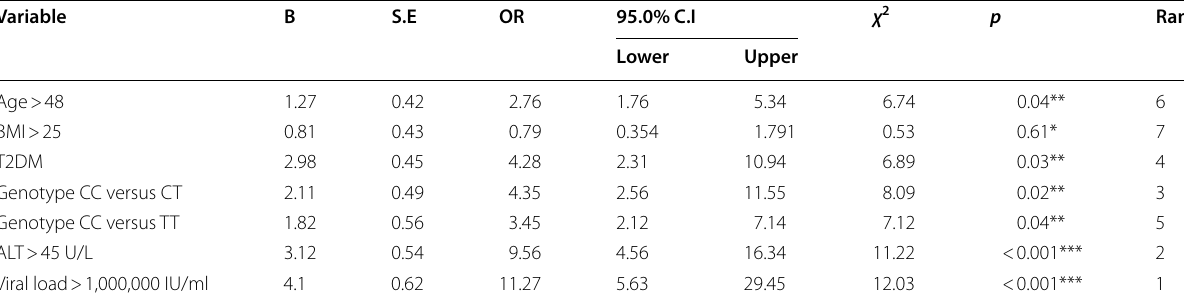
B coefficient of regression, S. E = significant p < 0.001